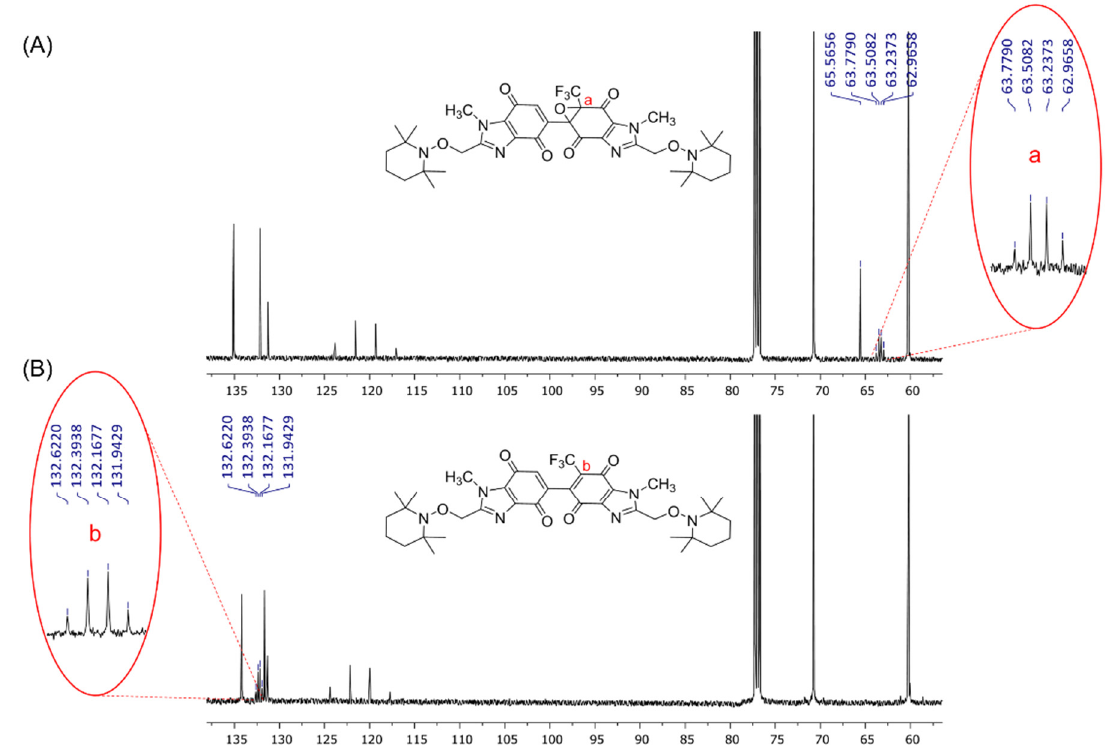
Figure 2. 13 C NMR spectra of ( A ) CF 3 -epoxide 1 and ( B ) CF 3 -Bis-TEMPO-Vis .